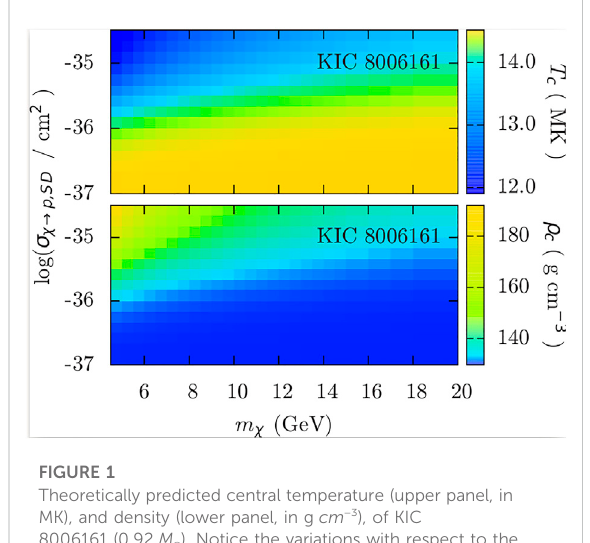
FIGURE 1 Theoretically predicted central temperature (upper panel, in MK), and density (lower panel, in g cm − 3 ), of KIC 8006161 (0.92 M ⊙ ). Notice the variations with respect to the asymmetric dark matter masses (m χ ) and baryon-dark matter spin-dependent cross sections (log ( σ χ → p )). Taken from Casanellas and Lopes (2013).